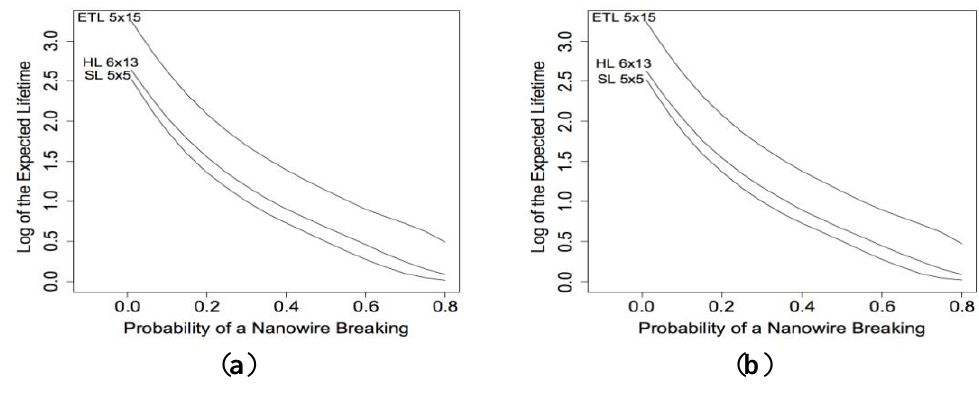
Figure 13. log E ( X ), log E ( X E ), and log E ( X H ) calculated using our algorithm 5 × 5 5 × 15 6 × 13 when β = 0.01 , β = 0.005, and β = 0.01, respectively when ( a ) the electrical current can move in all directions and when ( b ) movement is